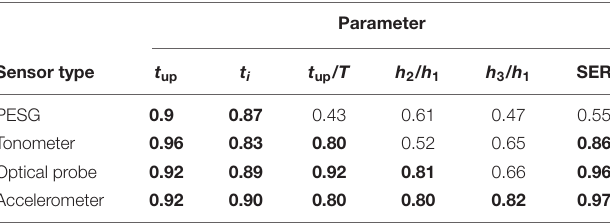
TABLE 7 | ICC of the parameters in the time and frequency domains for inter-observer